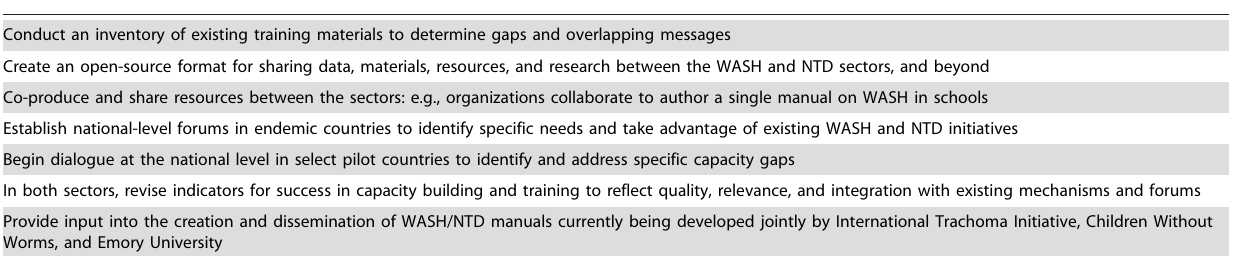
Table 5. Opportunities and next steps in capacity building and training.